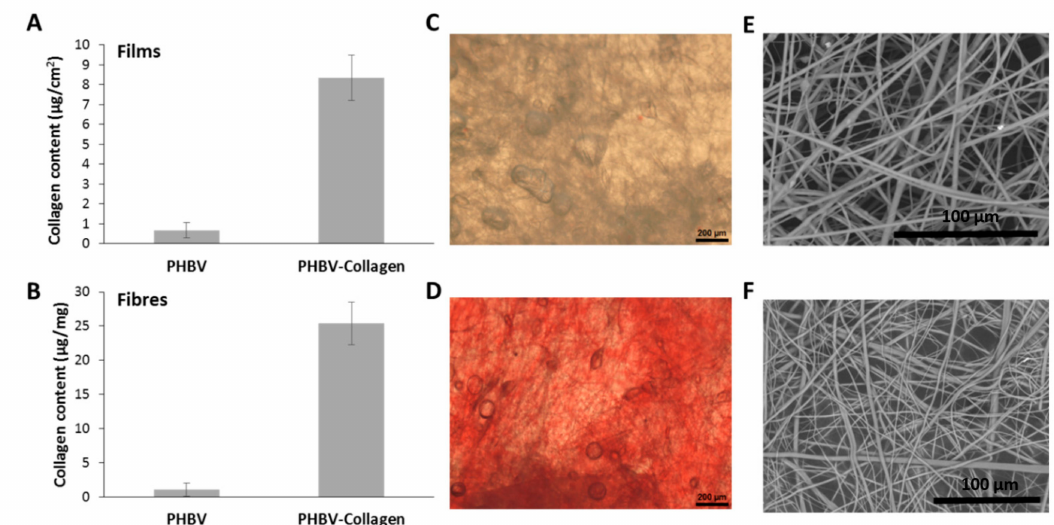
Figure 2. Quantification of collagen content by Sirius Red Assay in ( A ). PHBV films (ug of collagen per area) and 3D fibrous mesh fabricated by forcespinning (ug of collagen per mass of fibres) ( B ). Microscopy of 3D fibrous PHBV mesh stained with Sirus Red ( C ) before, and ( D ) after, collagen functionalisation. SEM image of fabricated sca ff olds by forcespinning ( E ) before, and ( F ) after collagen grafting. Scale bar in SEM corresponds to 100 µ